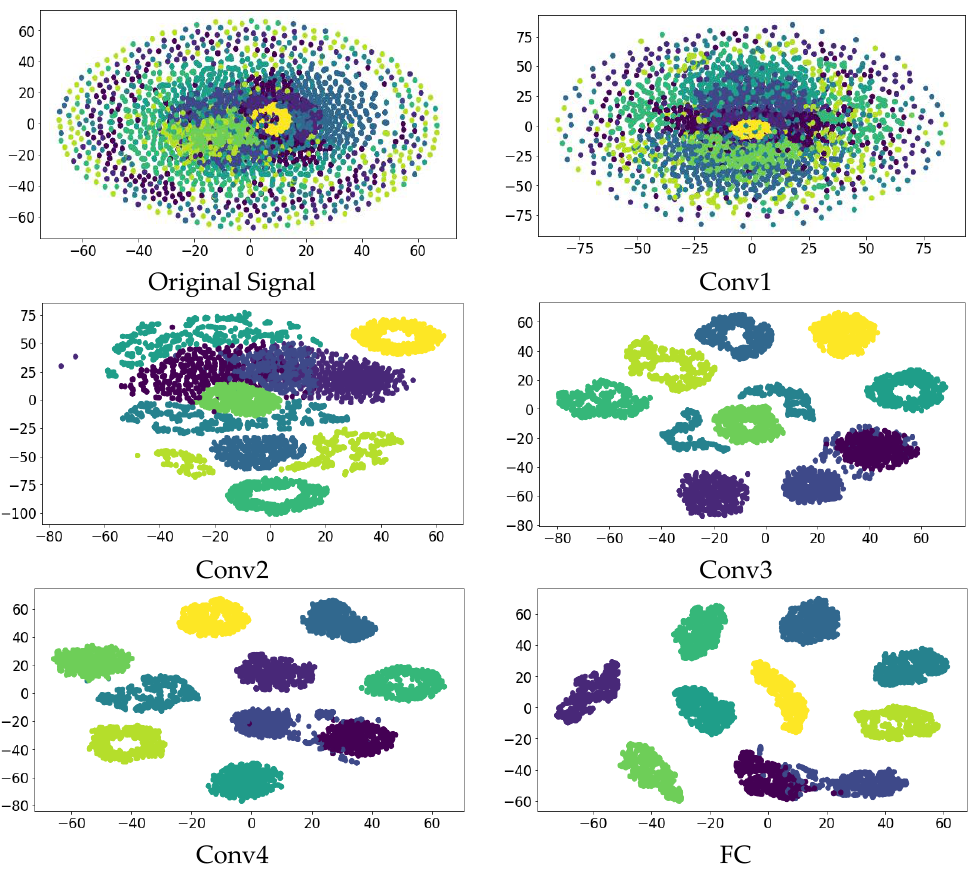
Figure 9. Feature visualization via t-SNE: feature representations for all test signals extracted from raw signal, four convolutional layers and the fully connected layer respectively.